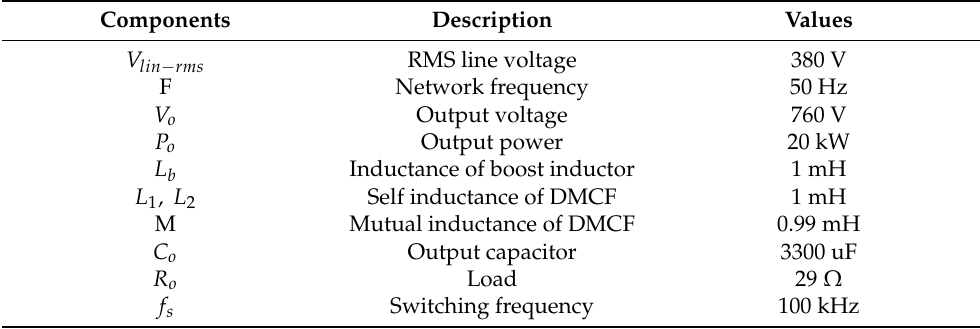
Table 1. Parameters used in the simulation.